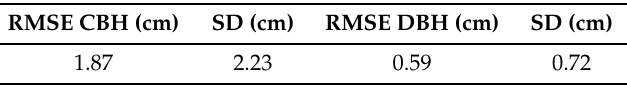
Table 1. The root mean square error (RMSE) of circumference in breast height (CBH) calculated from photo reconstructed models and the terrain measurement using common dendrometric tape, and RMSE of diameter in breast height (DBH). Both values include standard deviation (SD).